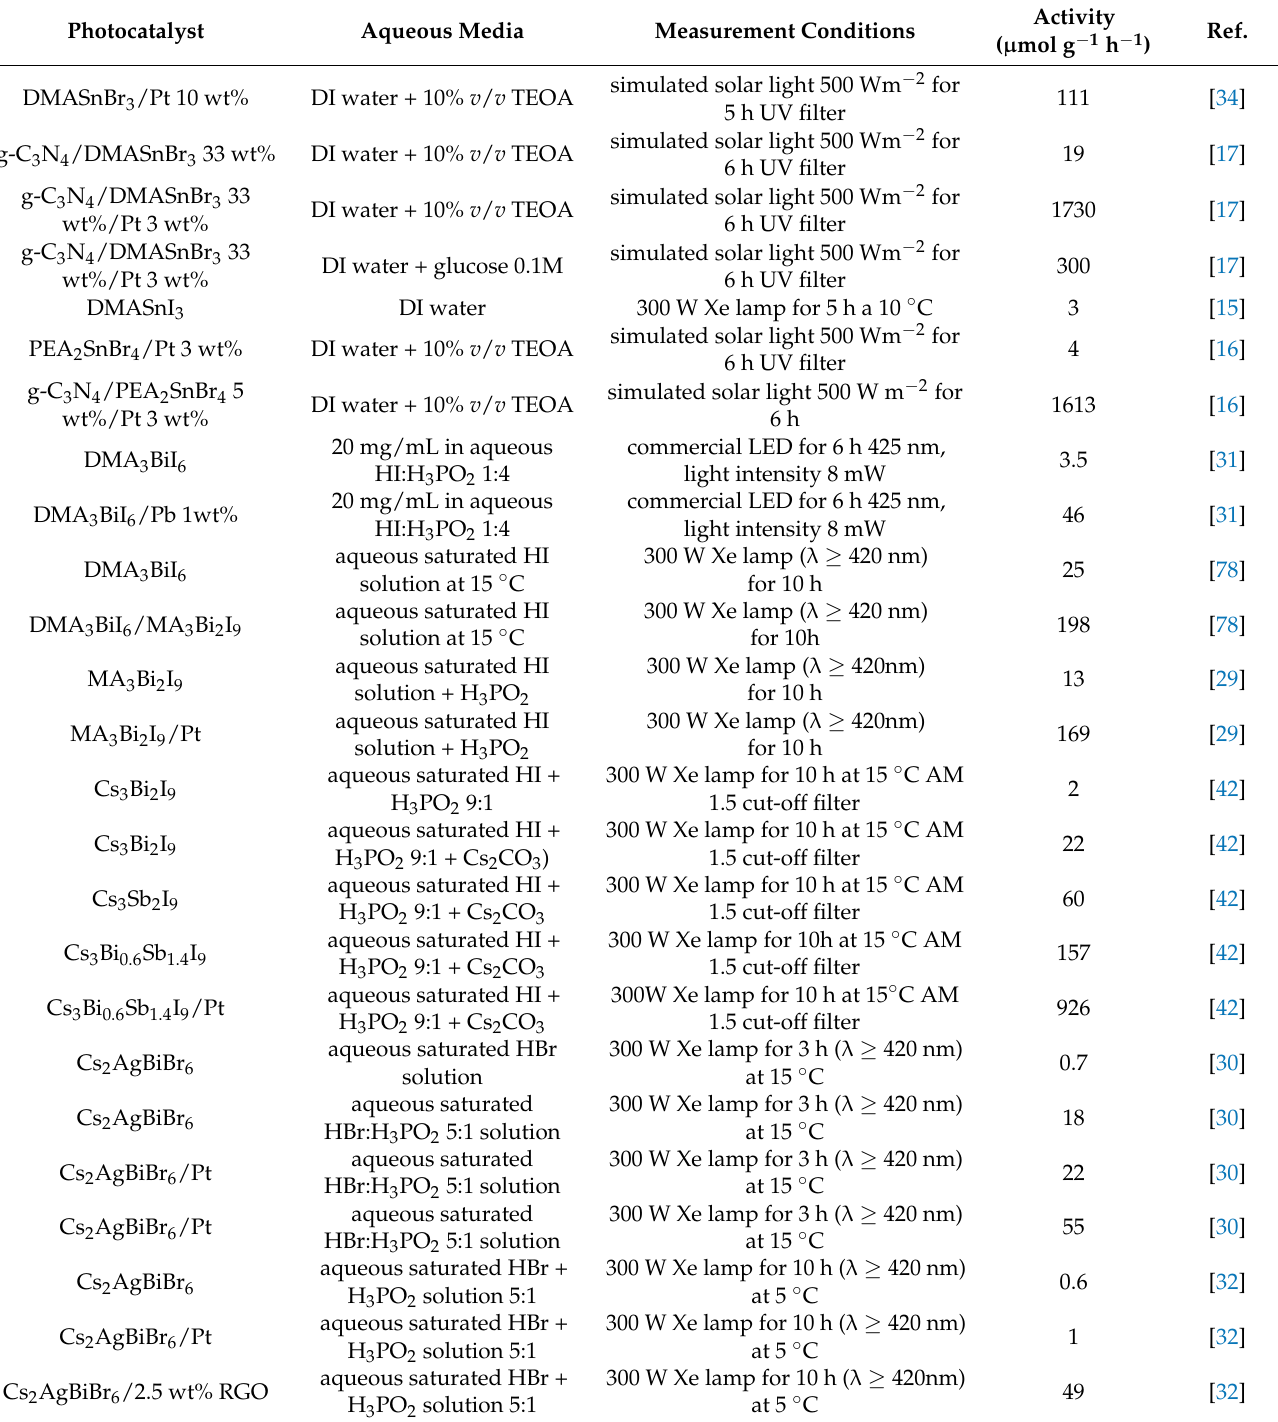
Table 1. Summary of the photocatalytic metal halide perovskite (MHP) systems discussed in this review.